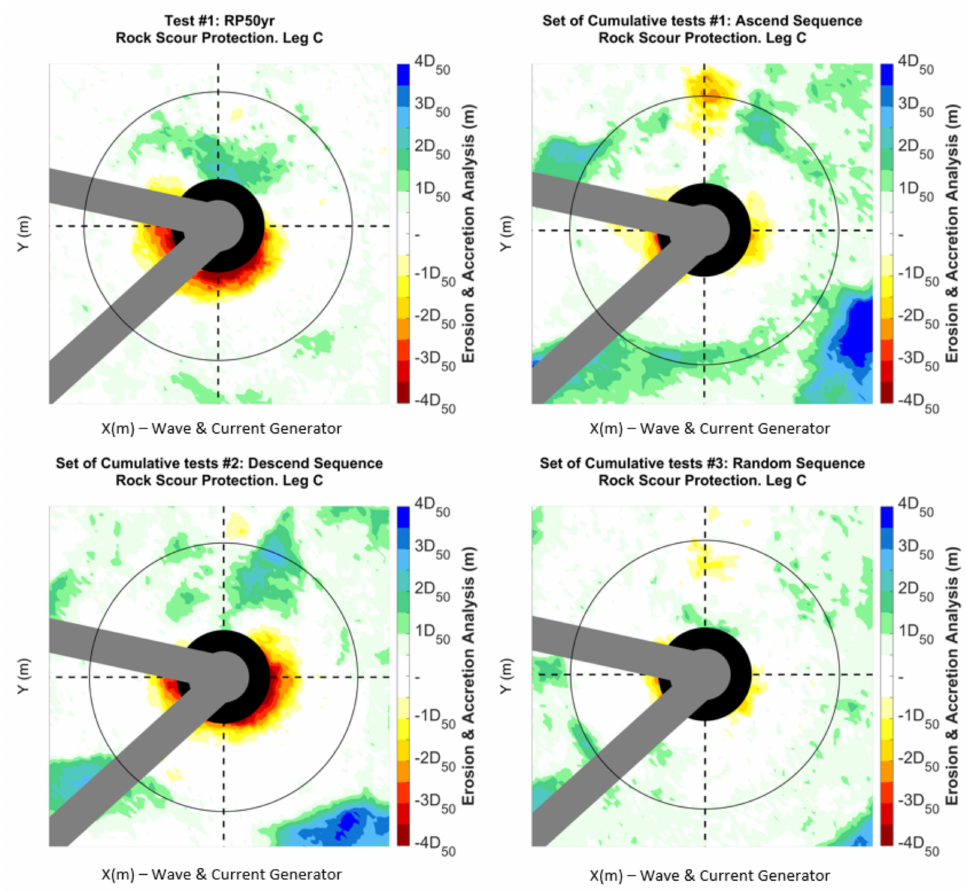
Figure 11. Leg C: extra increase rock protection. Top left : individual, top right : cumulative ascending, bottom left : cumulative descending, bottom right : cumulative random.